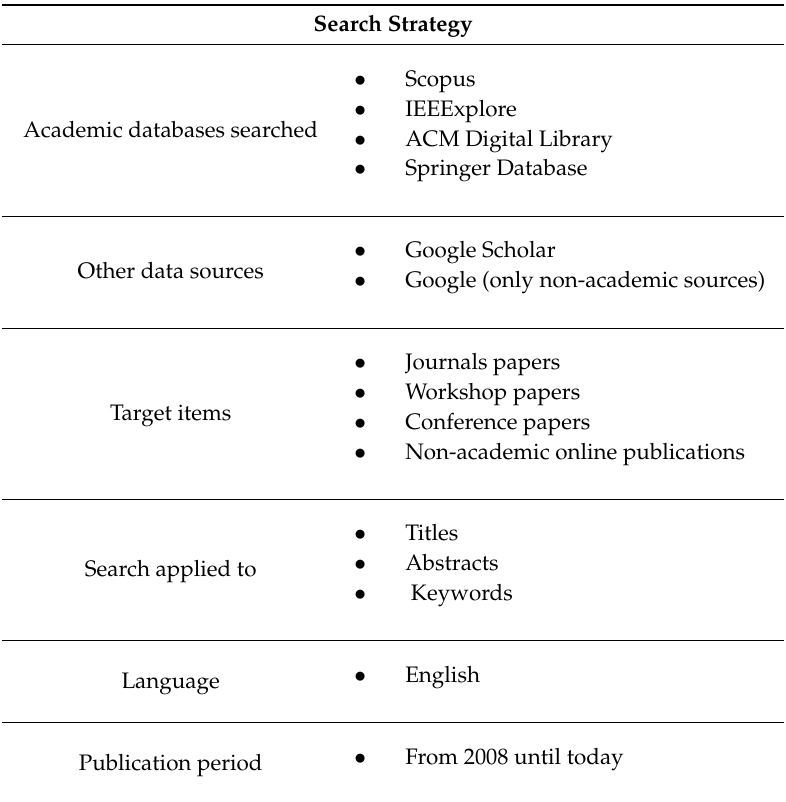
Table 3. Summary of the search